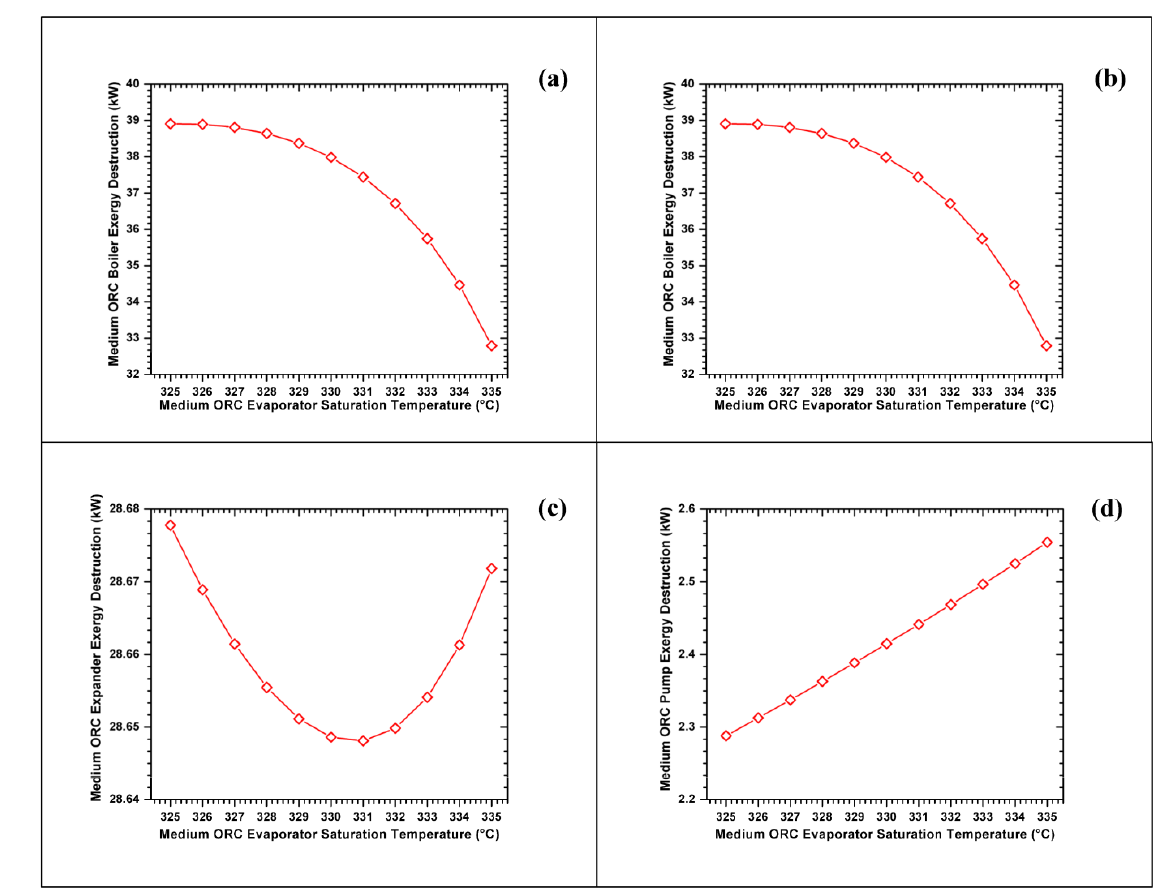
Figure 5. The exergy destruction rates of different components of ( a ) boiler, ( b ) condenser, ( c ) expander, ( d ) pump of the M-Xylene ORC against its boiler saturation temperature.